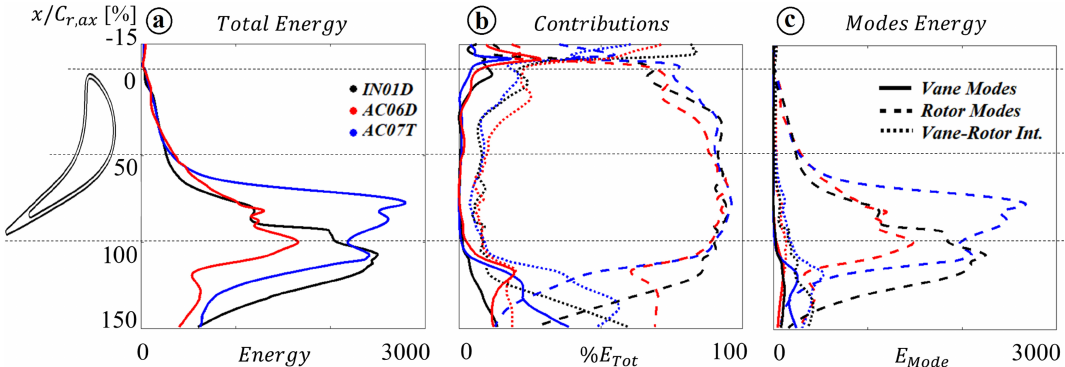
Figure 11. Modal decomposition of mid-gap entropy field: total energy ( a ); mode contributions ( b ); and mode absolute energy spectra ( c